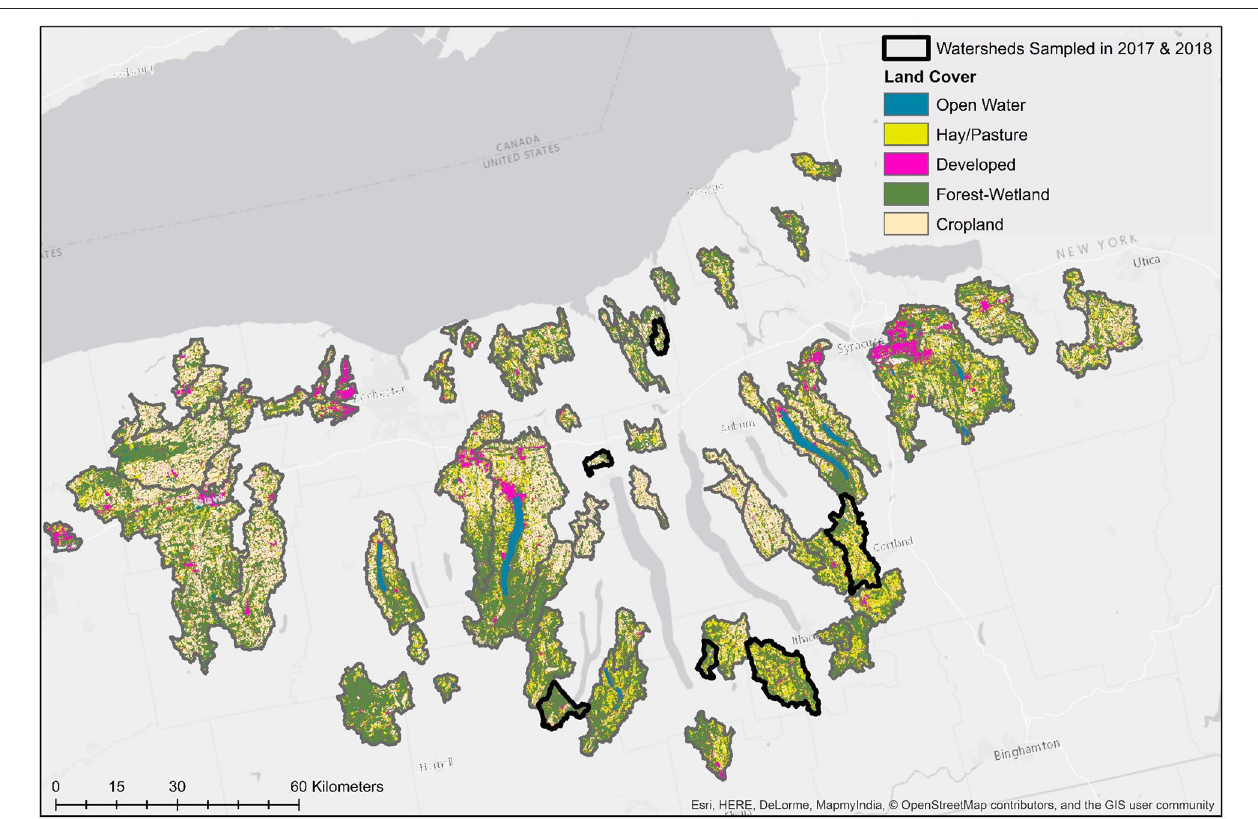
FIGURE 1 | Map of land cover in watersheds sampled in both study years (No. = 6), and watersheds sampled only in 2018 (No. =